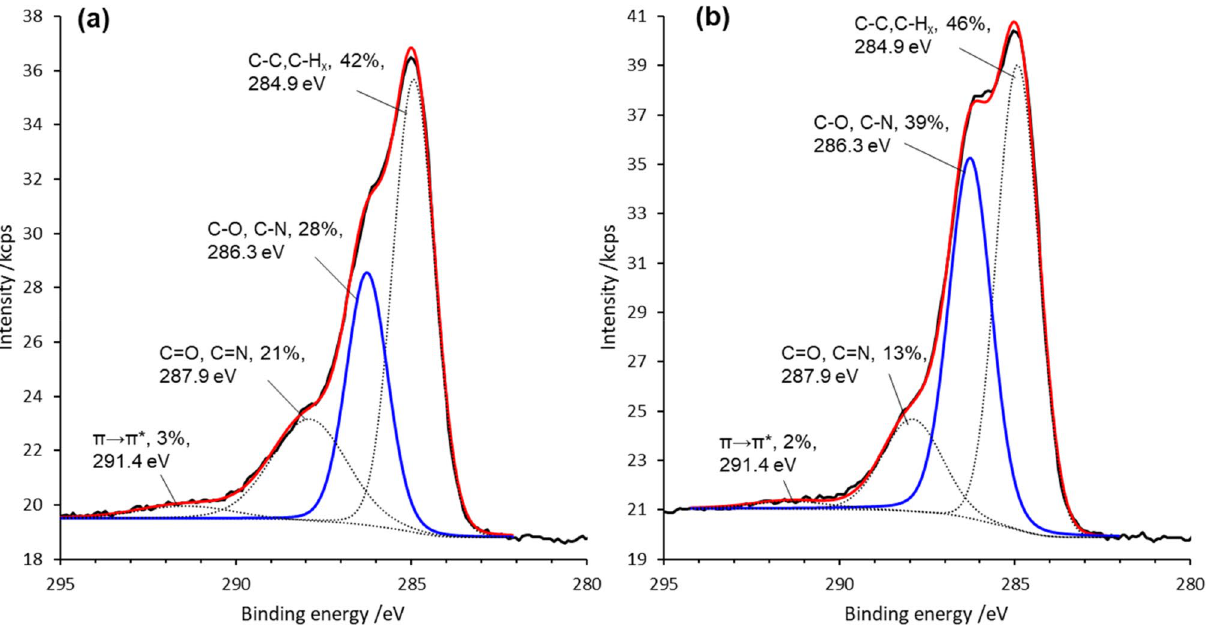
Figure 5. XPS spectra of C 1s region of pristine polydopamine (ePDA) ( a ) and one-step modified polydopamine (ePDA-ETA) ( b ).